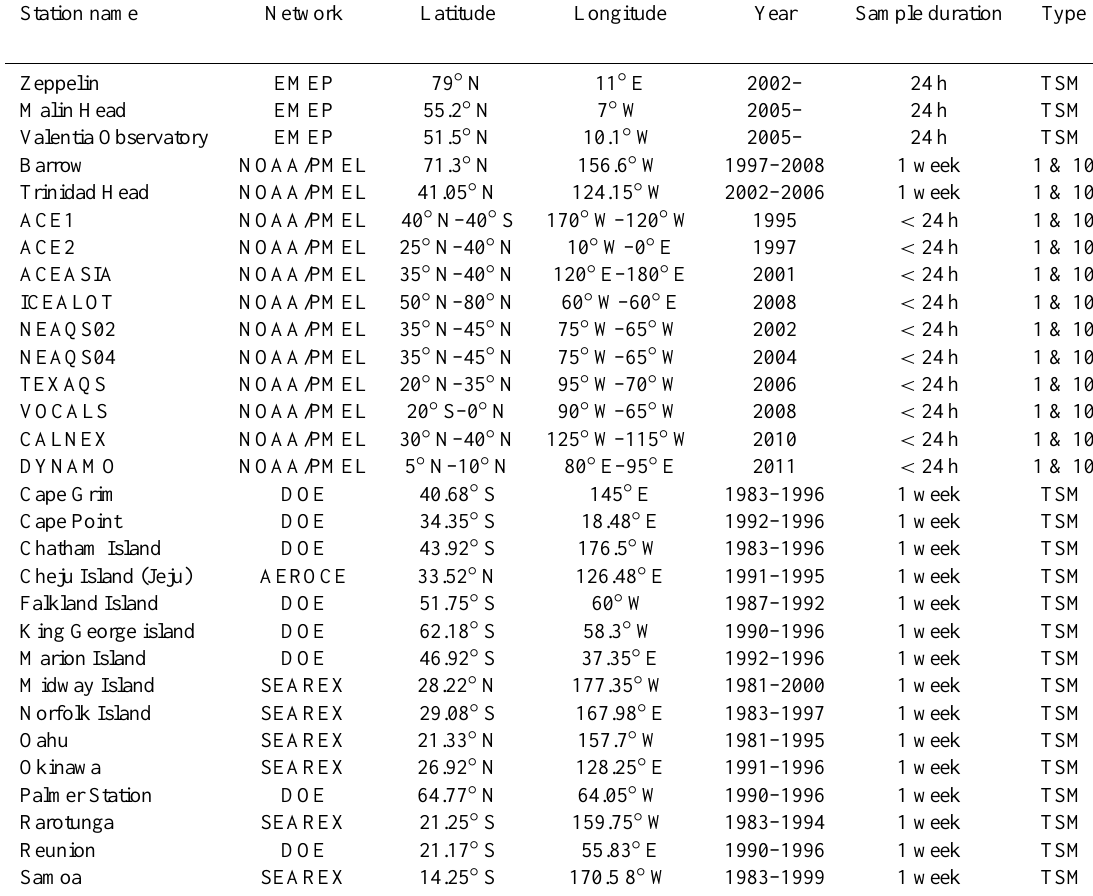
Table 1. Overview of the observation data used in this study. The station/cruise locations are plotted in Fig. 4. TSM is total suspended particulate matter, and “1 & 10” indicates PM 10